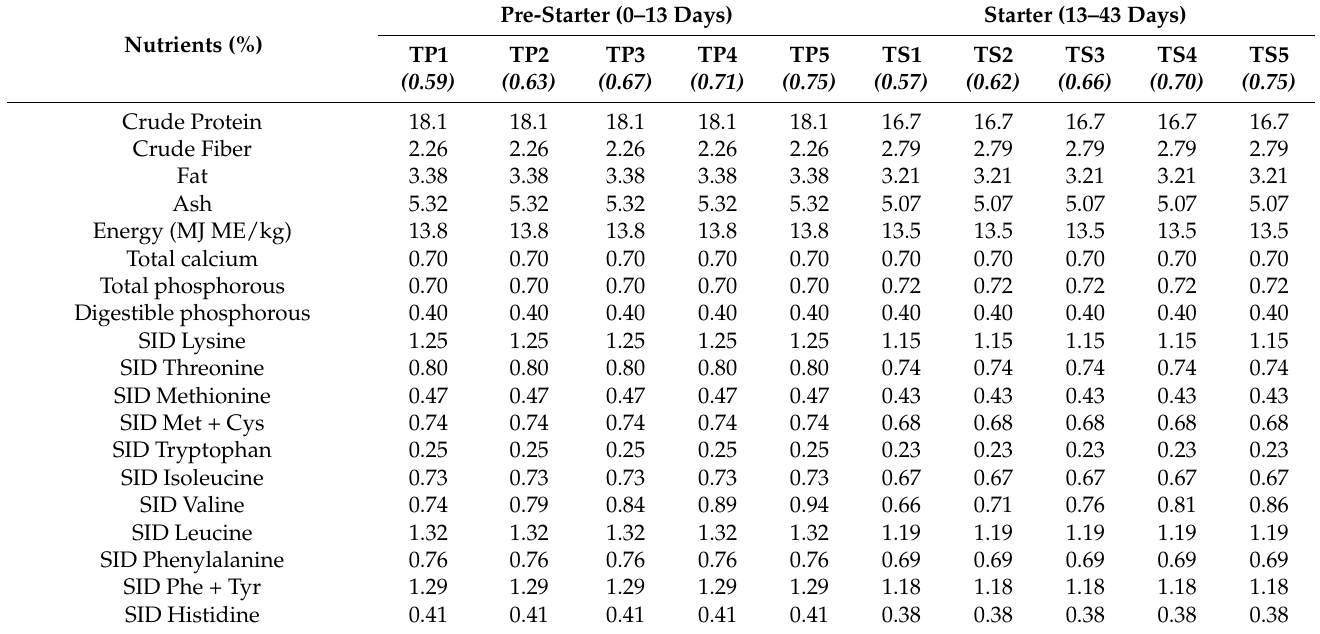
Table 2. Calculated nutritional composition of dietary treatments (T).